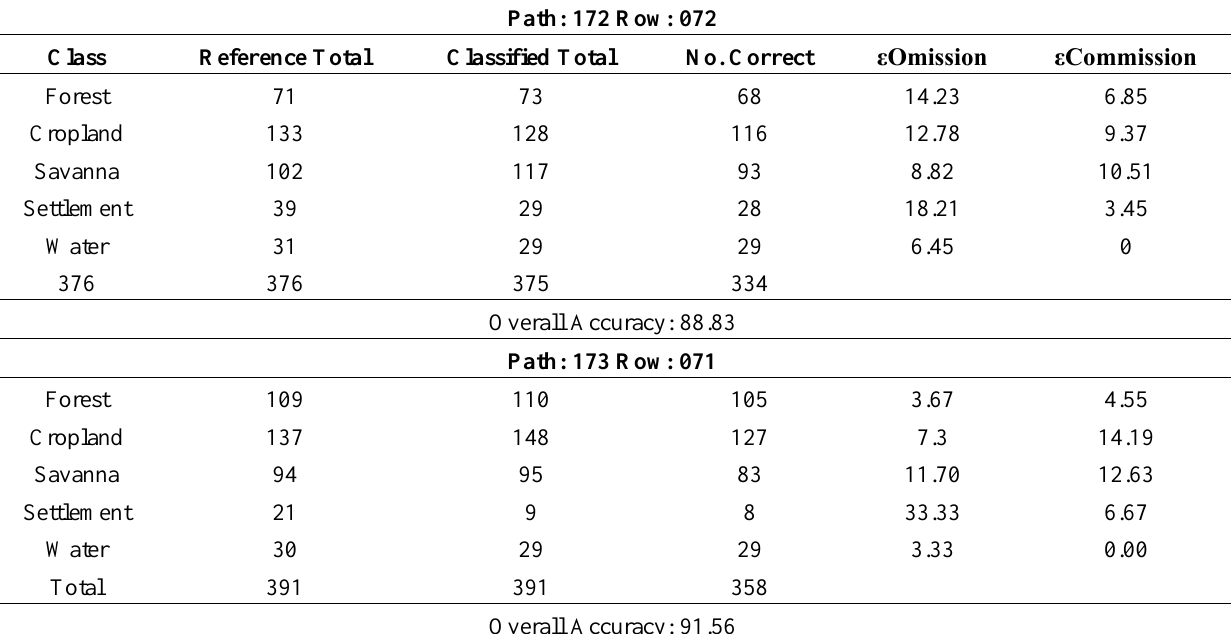
Table A4. Accuracy assessment of the southern adjacent classification at Path: 172 Row: 072 and western adjacent classification at Path: 071 Row: 073. Path: 172 Row: